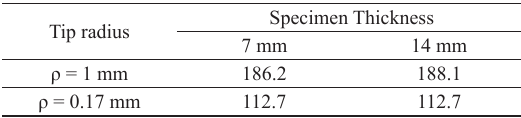
Table 7. Experimental values of K cexp (MPa√m) for U-notched specimens.